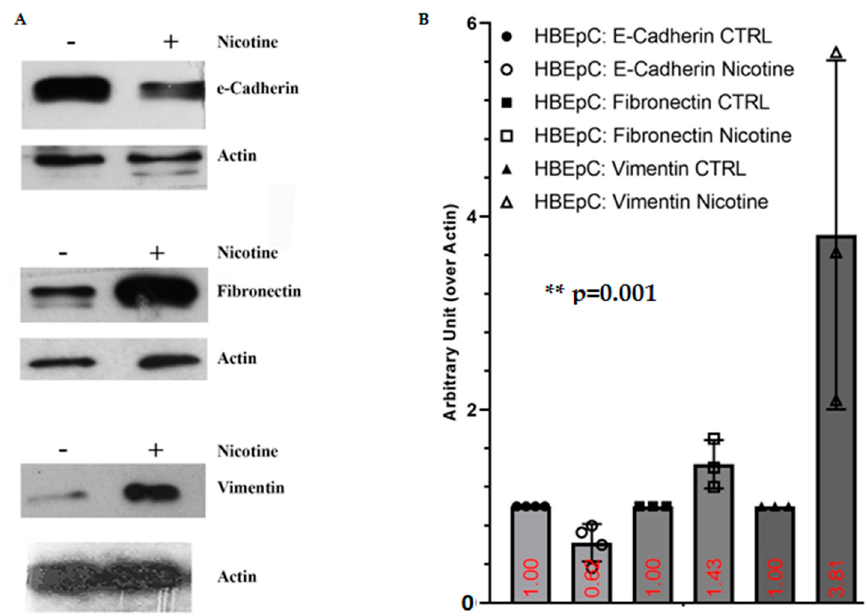
Figure 9. EMT induced by nicotine in HBEpC. ( A ): Western blotting; ( B ): densitometric analysis. Statistical significance is analyzed with one-way ANOVA with multiple-comparison and post hoc test with Bonferroni correction. Experiments are performed at least two times in triplicate. In the Supplementary Materials, raw data of Western blotting are